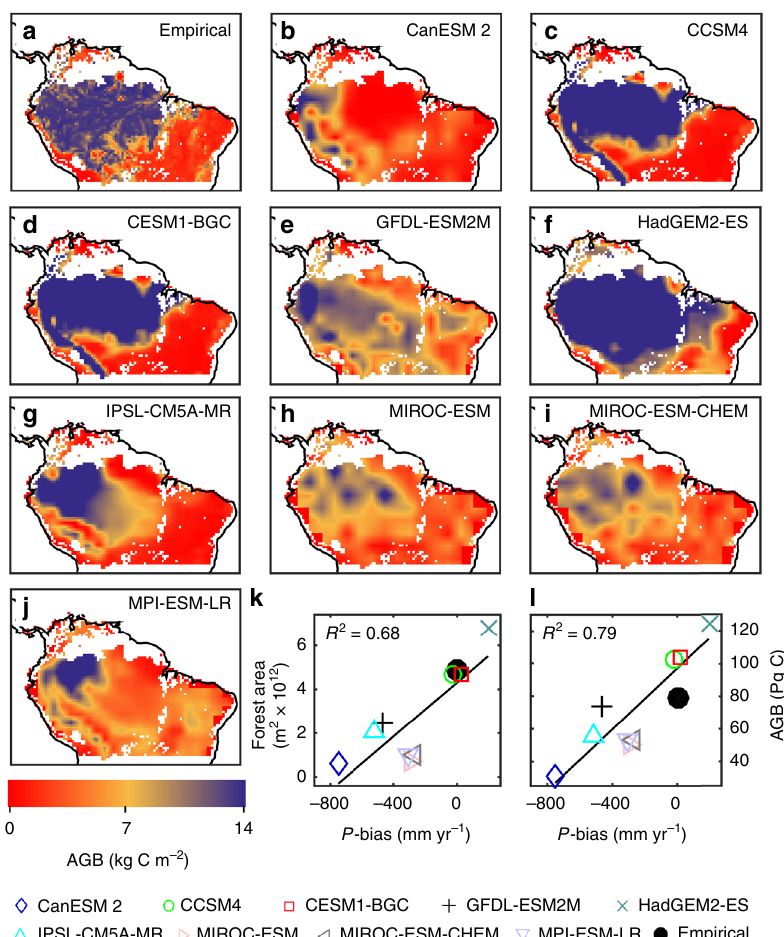
Fig. 2 Spatial above ground biomass distributions. a Empirical above ground biomass (AGB). b – j Earth system model (ESM) AGB. k Relationship between ESM-simulated tropical forest area and precipitation ( P ) bias over the Amazon basin and surrounding semi-arid regions. The forest area was de fi ned as the sum of the area of all grid cells with AGB > 10 kg C m − 2 in maps b – j . Symbols follow legend of Fig. 1 and the empirical data set is shown as a solid black circle